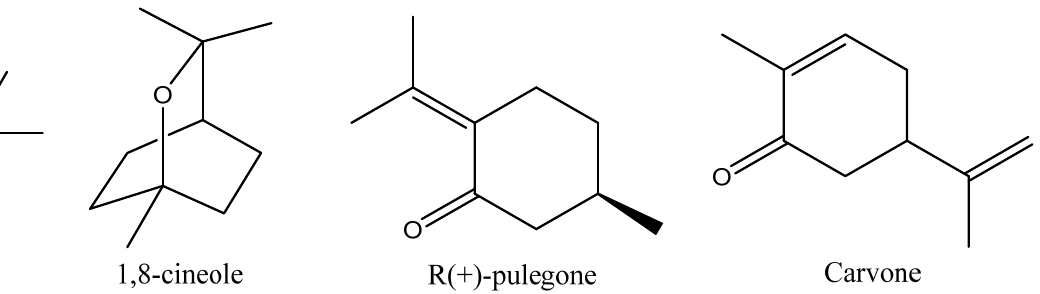
Figure 1. The molecular structures of the four monoterpenes as determined by ChemBioDraw software (version 16.0).